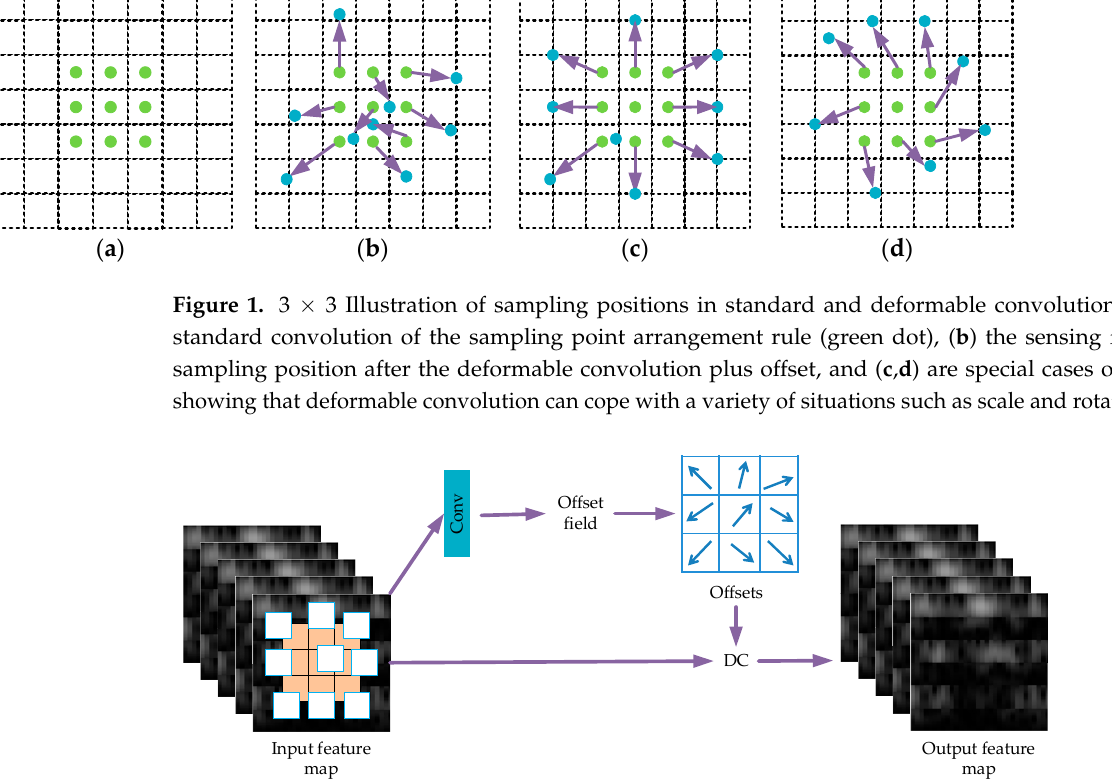
Figure 1. 3 × 3 Illustration of sampling positions in standard and deformable convolution, ( a ) stand- ard convolution of the sampling point arrangement rule (green dot), ( b ) the sensing field sampling position after the deformable convolution plus offset, and ( c ) and ( d ) are special cases of ( b ) showing that deformable convolution can cope with a variety of situations such as scale and rotation.